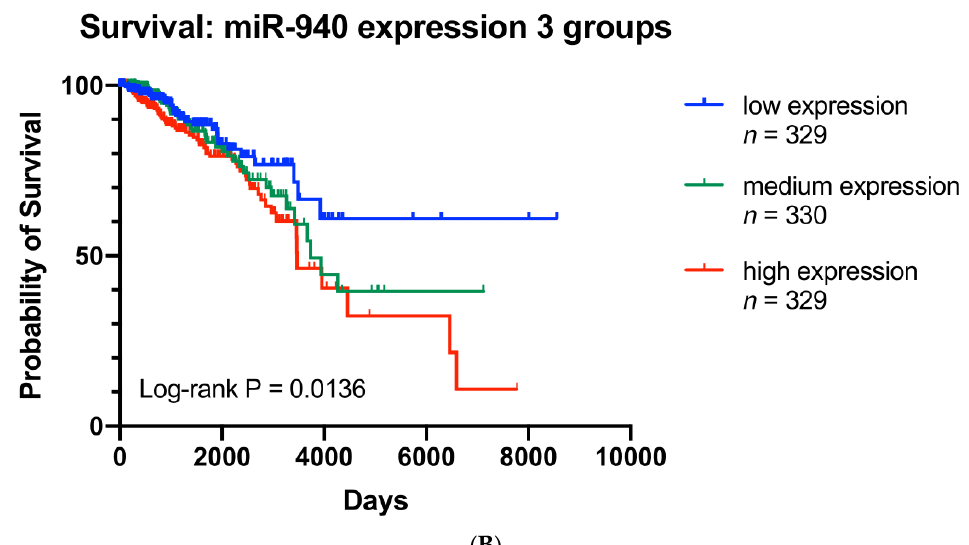
Figure 5. Analysis of hsa-miR-940 expression in breast cancer and adjacent normal breast tissues ( n = 105), as well as its expression in association with overall survival in TCGA. ( A ) Comparison of hsa-miR-940 expression between breast cancer and match adjacent normal tissues ( n = 105). ( B ) Kaplan–Meier overall survival (OS) curves by high, mid, and low expression of hsa-miR-940. Cancers 2022 , 14 , x